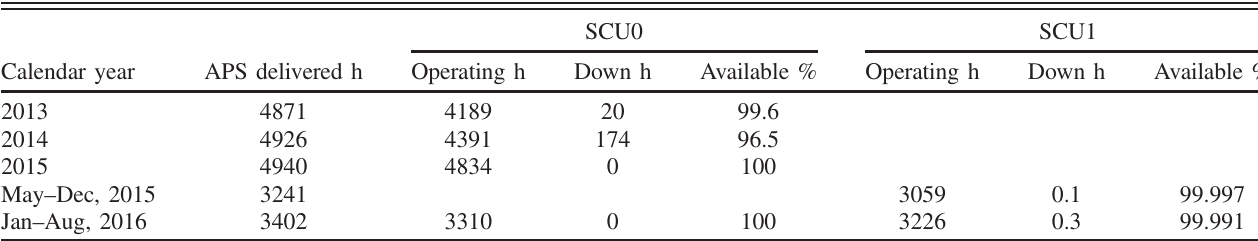
TABLE IV. APS SCU operational statistics.